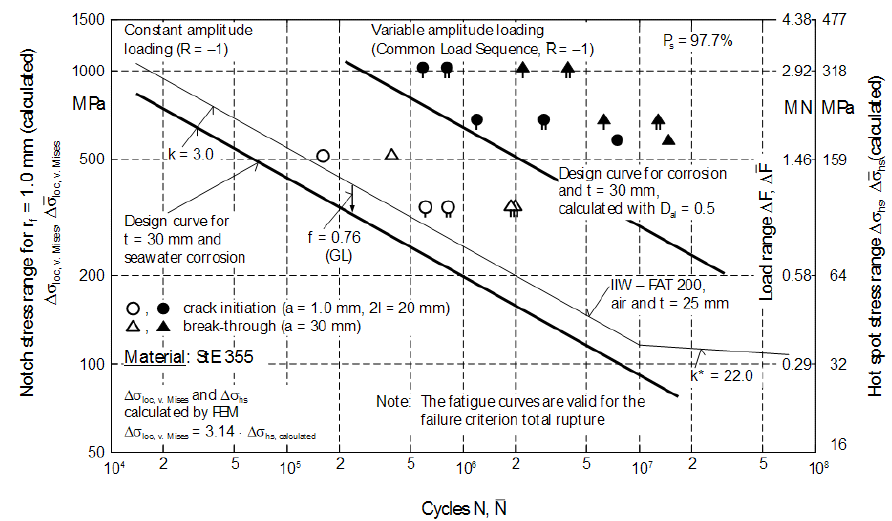
Figure 15: Application of the notch stress concept with r ref = 1.0 mm for the evaluation of welded K-nodes.